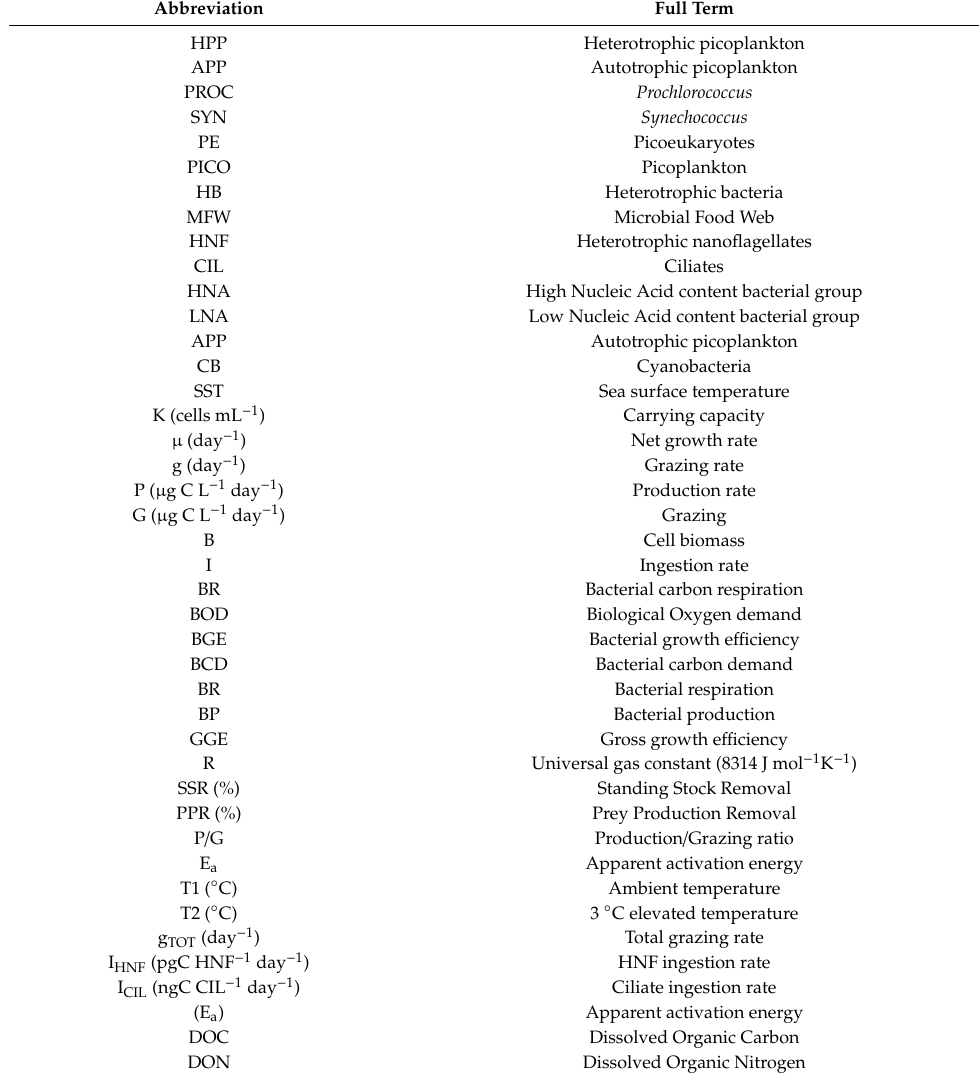
t -test for dependent samples. Percentage changes in parameter values in increased temperature conditions (T2) compared to initial ambient temperature (T1) were noted in the last column (positive changes are bolded). Figure S1. Biomass changes throughout experiments. A, high nucleic-acid bacteria; B, low nucleic-acid bacteria; C, Prochlorococcus ; D, Synechococcus ; E, picoeukaryotes; F, heterotrophic nanoflagellates. Full lines represent ambient temperature and dashed lines –3 ◦ C elevated